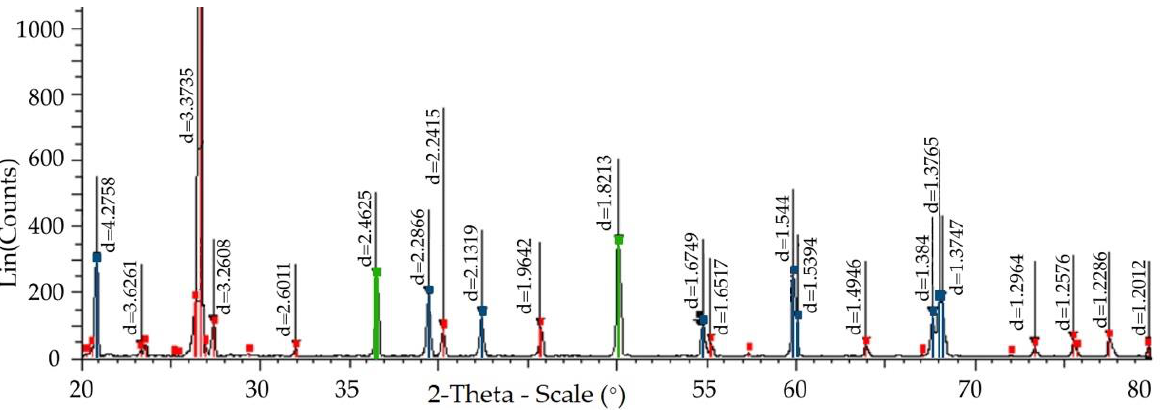
Figure 5. The X-ray diffraction patterns of quartzite taken at 30 °C, where green indicates peaks for 01-083-2187, and peaks for 01-070-7344 are marked in blue.